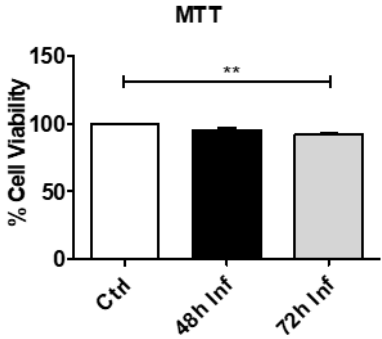
Figure 1. Crandell–Rees feline kidney (CRFK) cell viability after canine coronavirus (CCoV) infection. CRFK cells were infected with CCoV at MOI of 400 infectious units (IFU) in an exosome-free medium and incubated for 48 h and 72 h; post-incubation cells were further incubated with 3-(4, 5-dimethylthiazol-2-yl)-2,5-diphenyltetrazolium bromide (MTT) dye solution at 37 ◦ C for 3–4 h and absorbance was read at 570 nm. Statistical analysis of obtained data points was performed using one ‐ way analysis of variance (ANOVA) with Tukey post hoc analysis. Statistical significance is indicated by the mean ± standard deviation (SD) and is defined as p ≤ 0.01 (**).